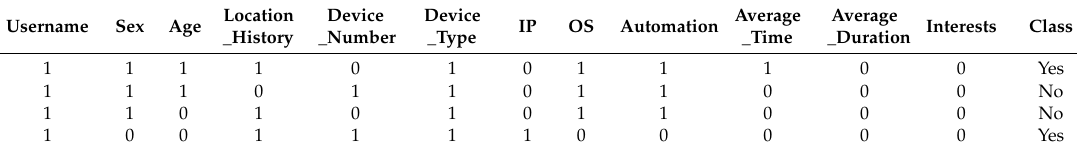
Table 2. Table 1 after applying the